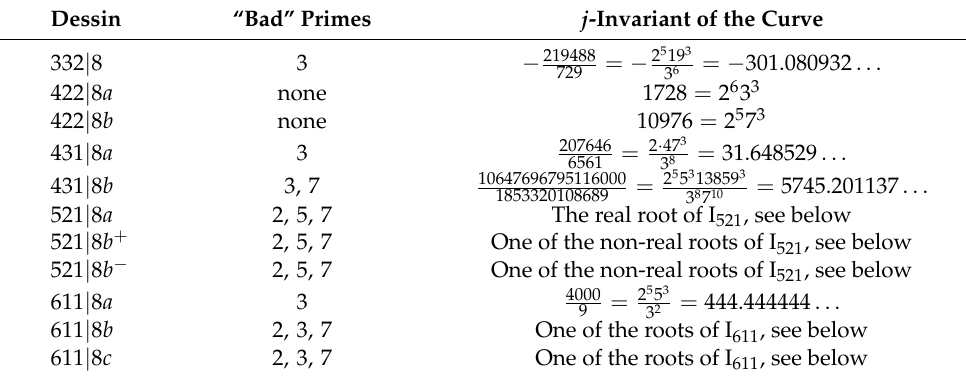
One of the roots of I 611 , see below Table 2. Norms of irrational j -invariants. Galois Orbit Norm of j -Invariants { 521 | 8 a , 521 | 8 b + , 521 | 8 b −